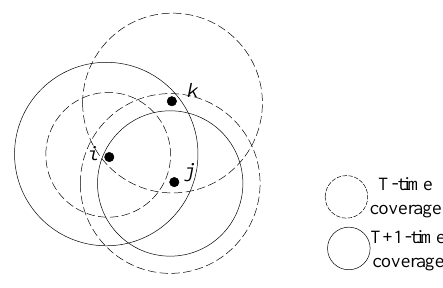
Figure 2. Diagram of power adaptation.